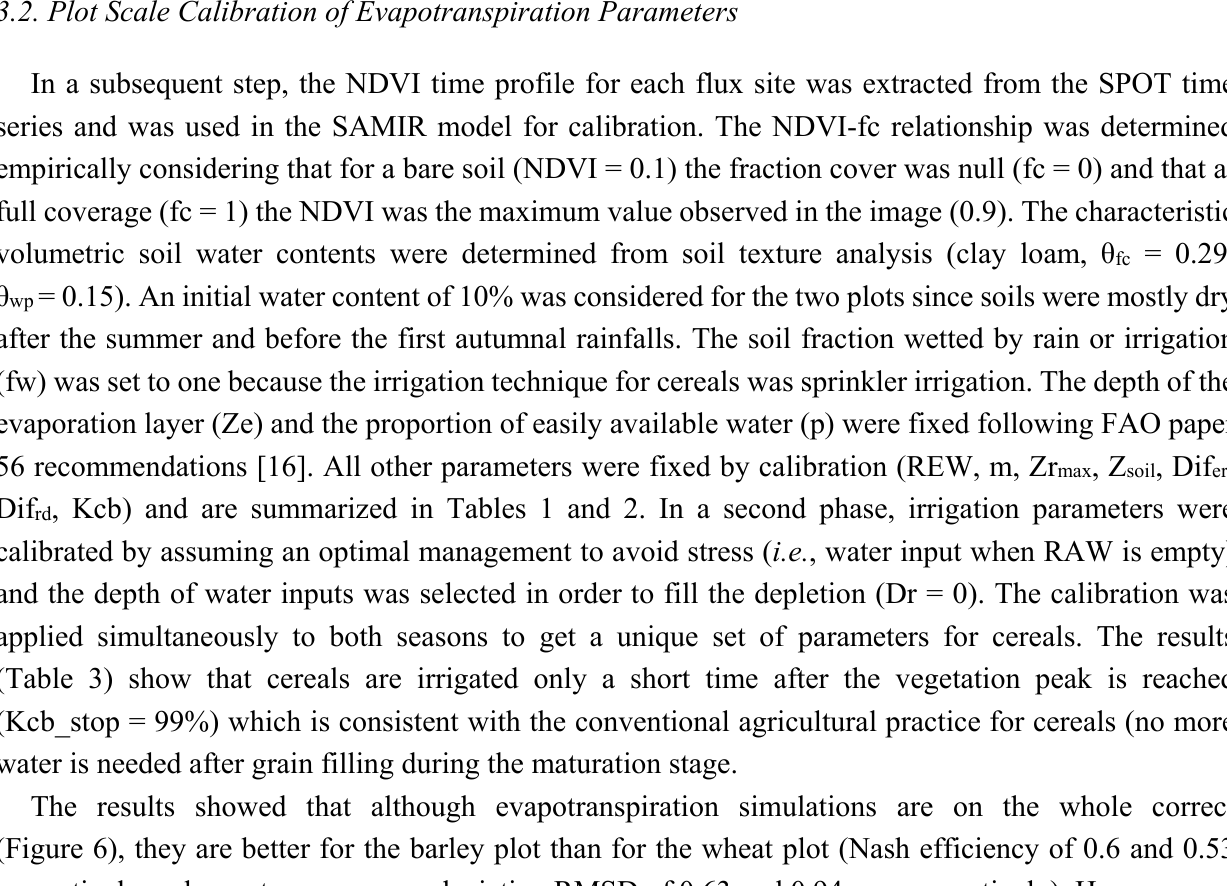
Figure 5. Comparison between the average reflectances of the 28 invariants for the SPOT5 and SPOT4-Take5 time series before